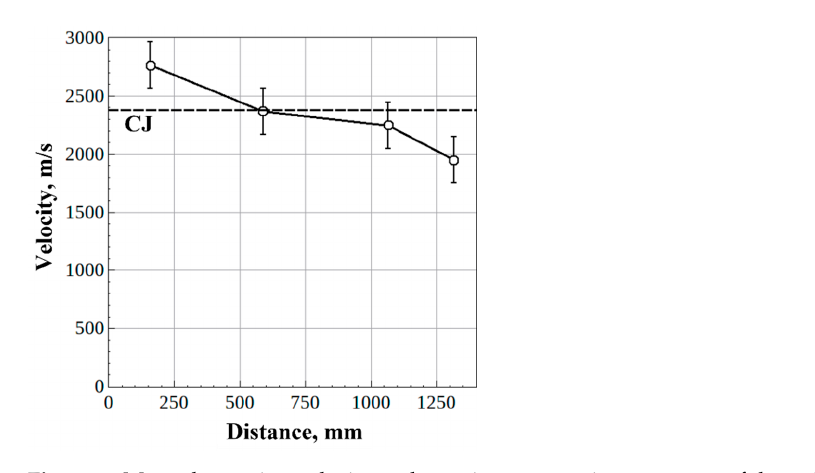
Figure 5. Example of ionization probe readings in one of operation cycles.